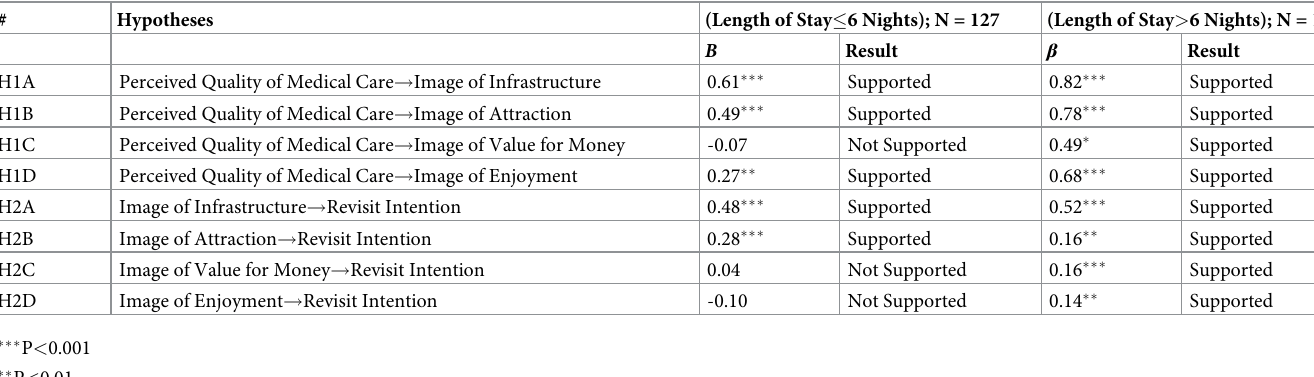
Table 5. Path analysis results—length of stay.